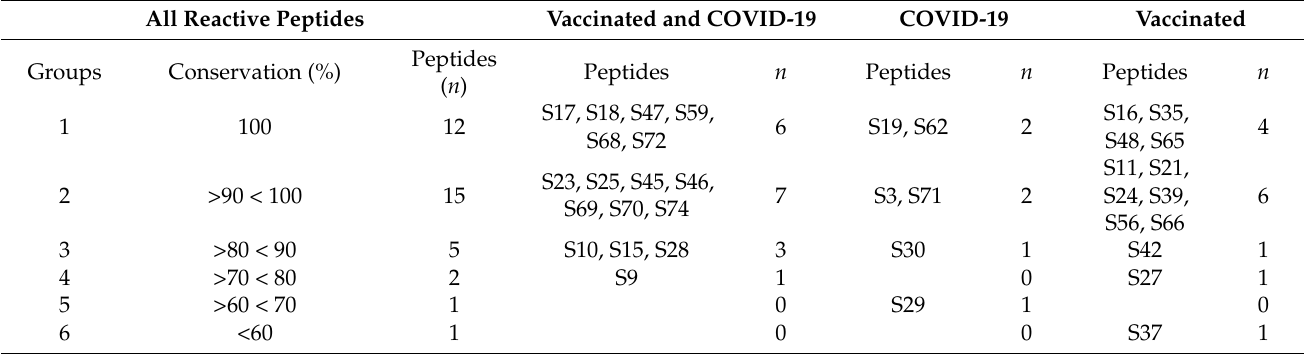
Table 2. Conservation analysis of S protein peptides grouped by type of sera. All Reactive Peptides Vaccinated and COVID-19 COVID-19 Vaccinated Groups